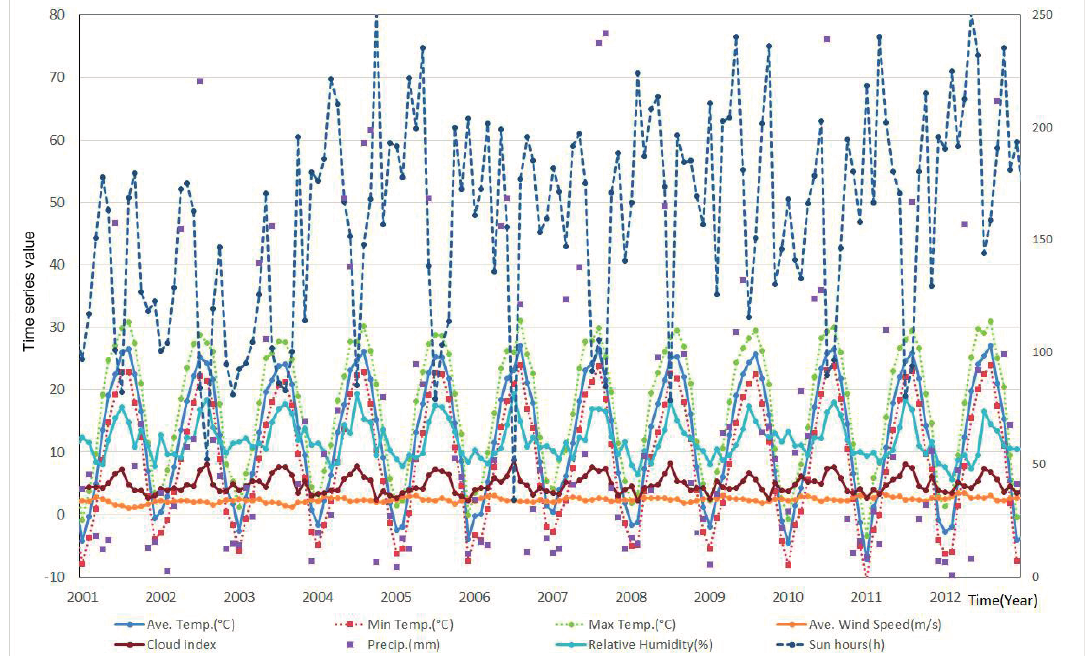
Figure 2. Weighted average meteorological data from Korea